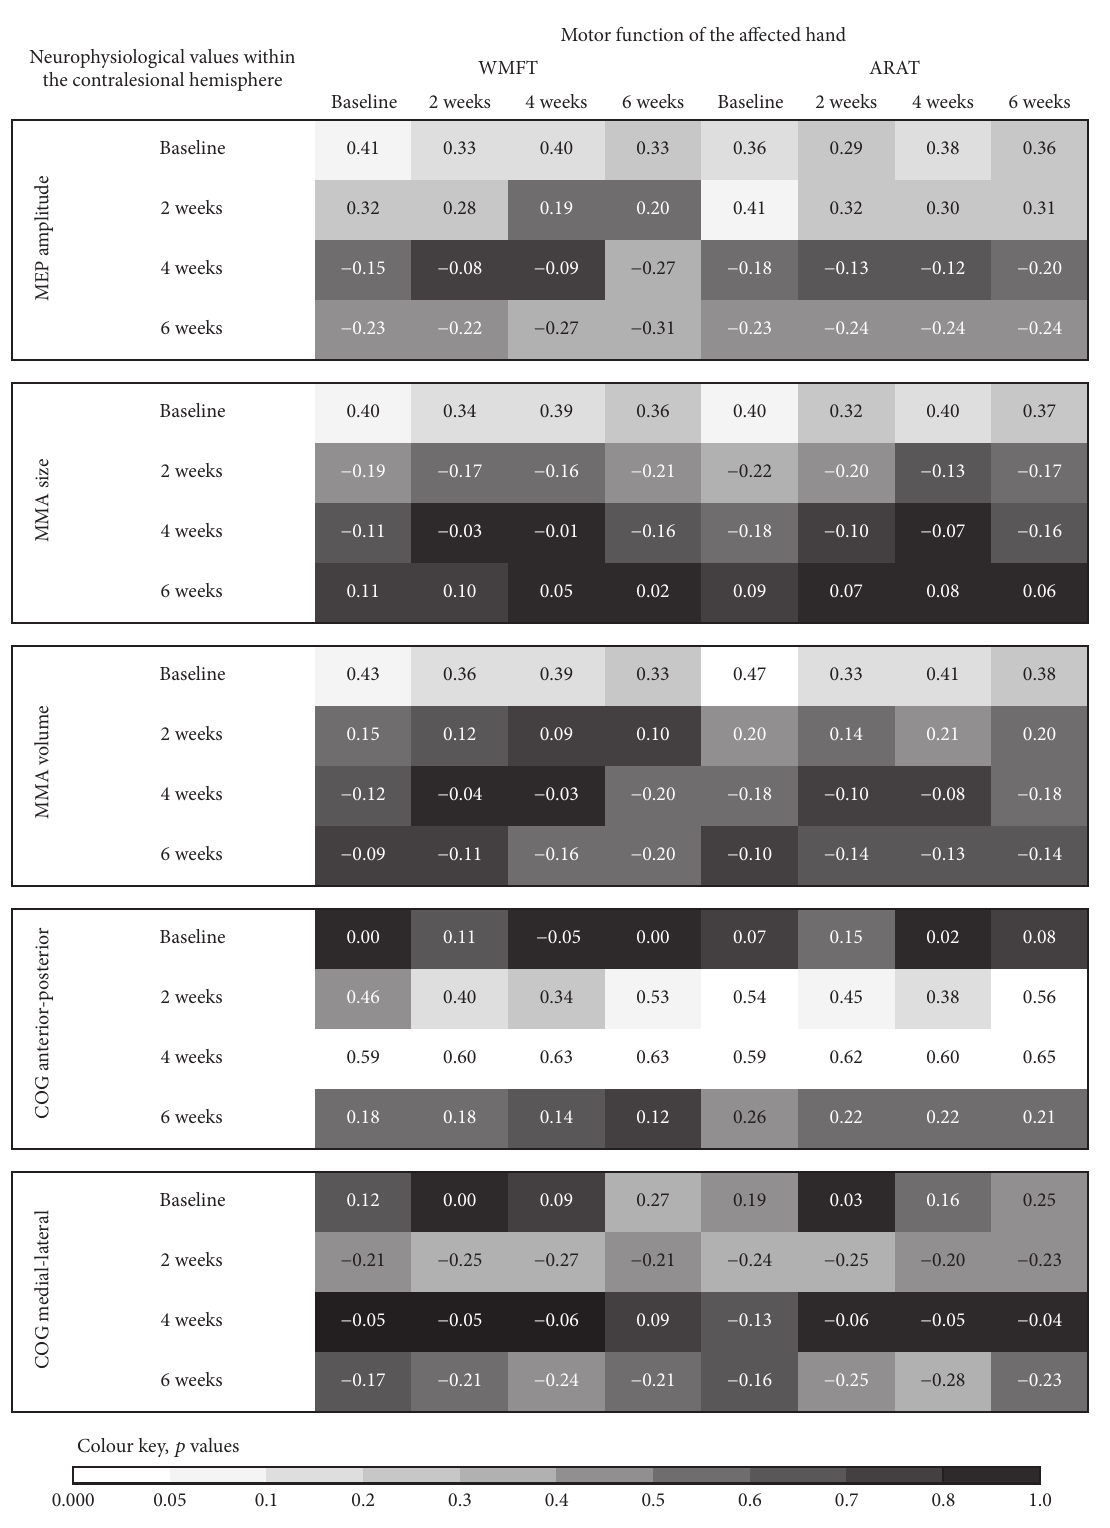
Figure 2: Correlation-coefficients between the neurophysiological values within the contralesional hemisphere and motor function of the affected